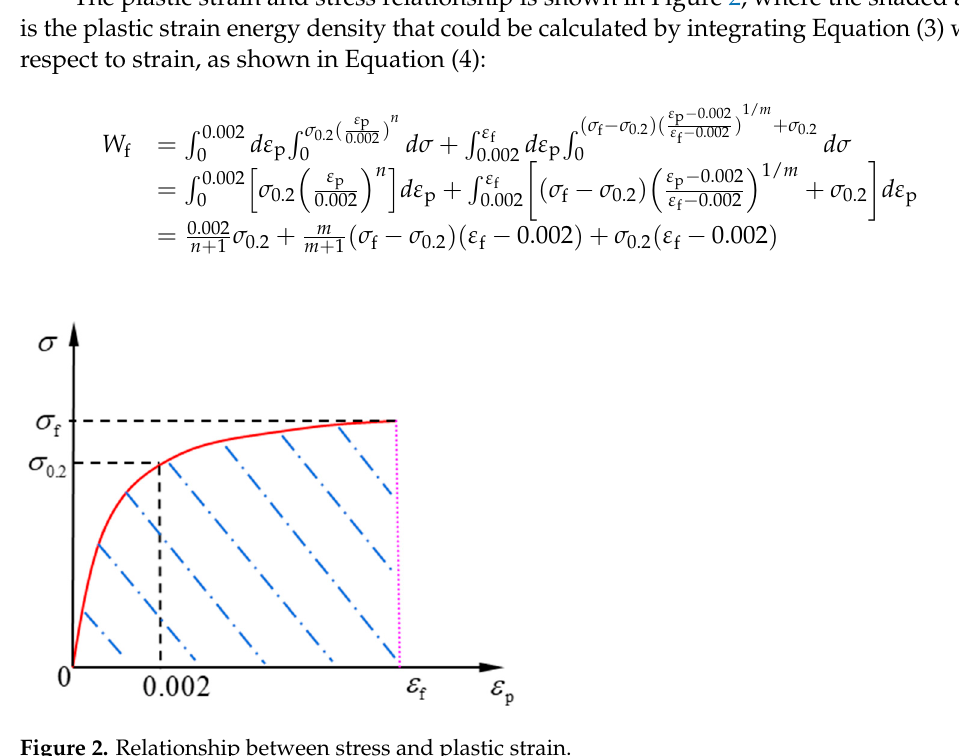
Figure 2. Relationship between stress and plastic strain.